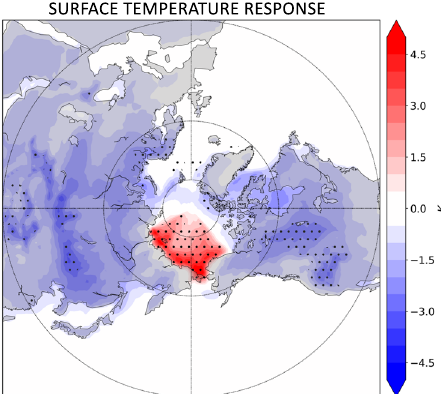
Fig. 10 Intensi fi ed cold air outbreaks induced by Paci fi c-sector Arctic sea ice loss following the onset. Composite of the surface temperature (K) response (CNTL-LOW) averaged from day 0 to day + 30 after the onset. Stippling indicates statistical signi fi cance at the 95%